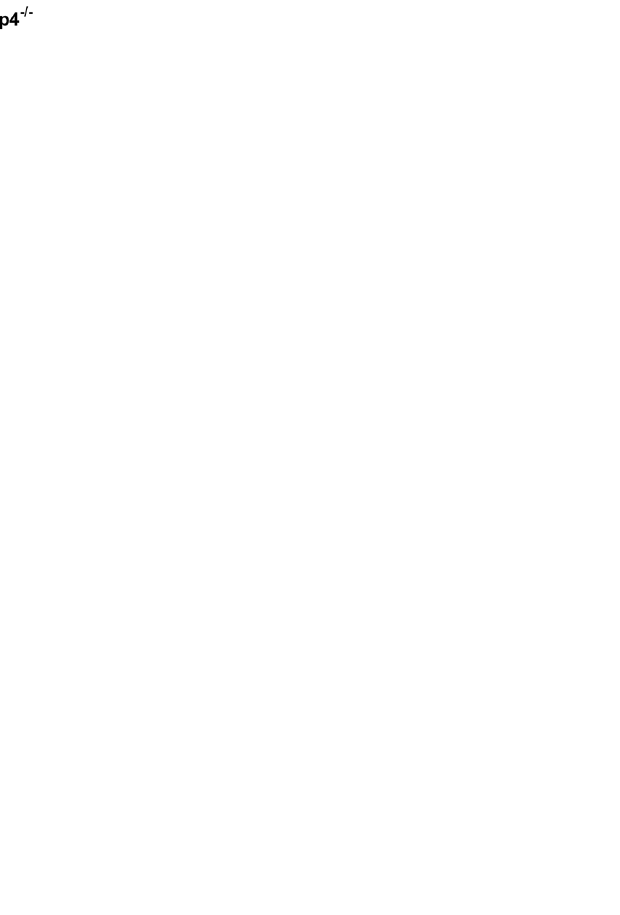
Figure 5. The BCRP inhibitor KO143 did not affect LPS-induced TNF a release in whole blood invitro and in BALF invivo . A ) Upon incubation with different concentrations of the BCRP inhibitor KO143 (1 m M, 10 m M) or PBS for control ( 2 ) for 30 min, TNF a release in whole blood samples from Mrp4 + / + mice (open bars) or Mrp4 2 / 2 mice (grey bars) was stimulated with LPS ( + , 600 ng/ml) or PBS for control ( 2 ). 4 h after stimulation, blood plasma was collected and TNF a concentrations measured. Result is representative for 3 independent experiments. n=3–4. n.s.=not significant. Data are mean 6 SEM. B) TNF a release in the BALF was measured in wt mice 4 h after application of LPS ( + ) or PBS for control ( 2 ). Mice were pretreated with MK571 (grey bars; 10 and 30 mg/kg), KO143 (striped open bars; 10 and 30 mg/kg), a combination of MK571 and KO143 (striped grey bars; 10 and 30 mg/kg of each inhibitor) or vehicle for control (open bar). n=8. n.s.=not significant. * p=0.006. Data are mean 6